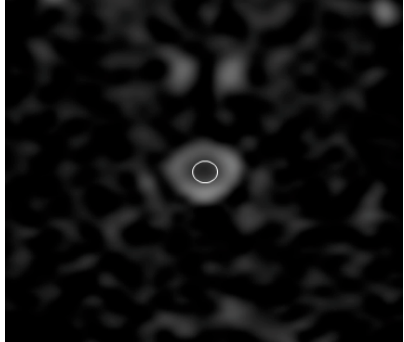
Figure 2. Apparent diffusion coefficient image of the C5 vertebra. The region of interest (ROI) is placed manually on the spinal cord with special care to include the least amount of cerebrospinal fluid. ROI size was standardized to 0.3 cm 2 .